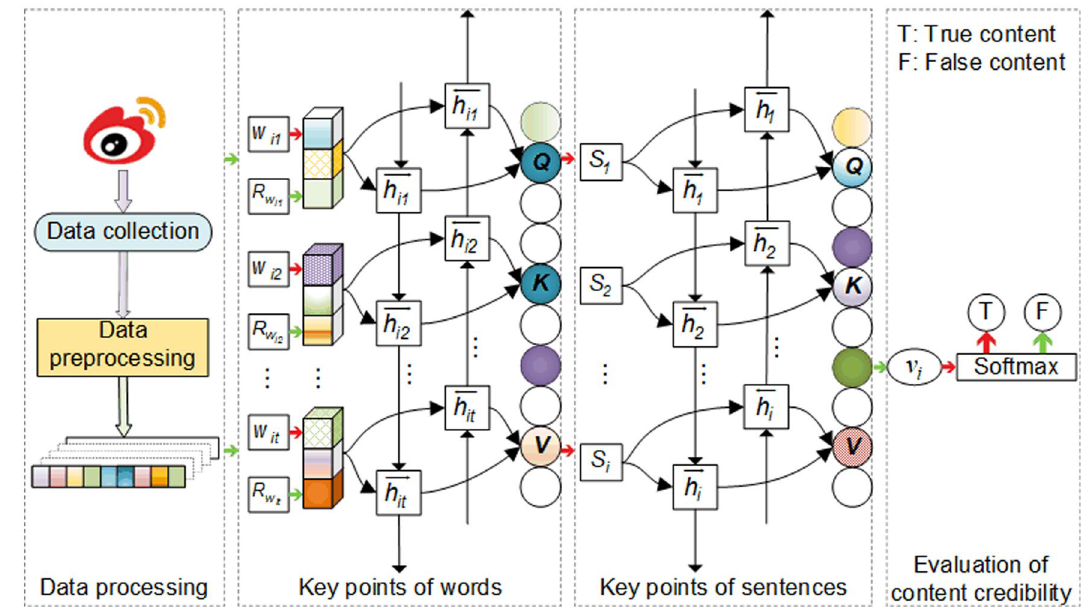
Figure 1. Microblog content credibility evaluation model based on collaborative key points.